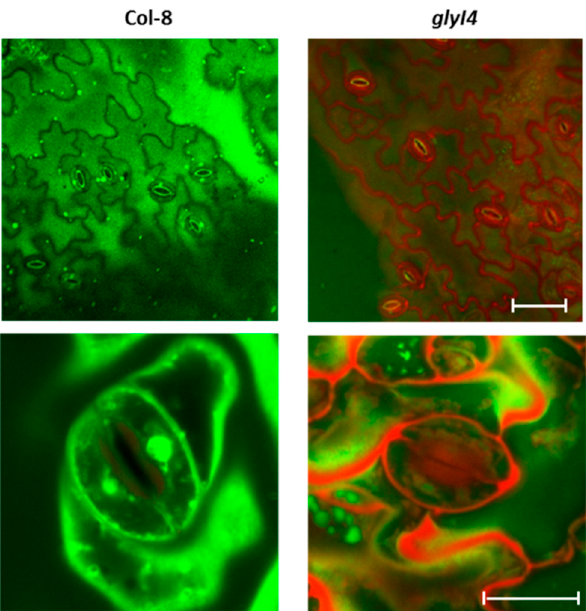
Figure 6. Confocal microscope representative images of stomatal guard cells of Arabidopsis Col-8 and glyI4 leaves. Abaxial peeled epidermis of Col-8 and glyI4 leaves was stained with acridine orange (AO) and observed by the confocal microscope. AO is colored in green in not acidified cell compartments while AO red color indicates an acidification of cellular compartments. Magnification of guards cells is also shown (lower panels). Fluorescence images were acquired using a Zeiss LSM 710 confocal microscope with Plan Neofluar 20/1.30 objective (upper panel) and Plan Neofluar 63/1.30 objective (lower panel). Fluorescence emissions of AO in the red and green channels (615 to 660 nm and 530 to 540 nm, respectively) after excitation with a 488-nm laser were obtained. Bar corresponds to 100 µm (upper panels) or 10 µm (lower panels).